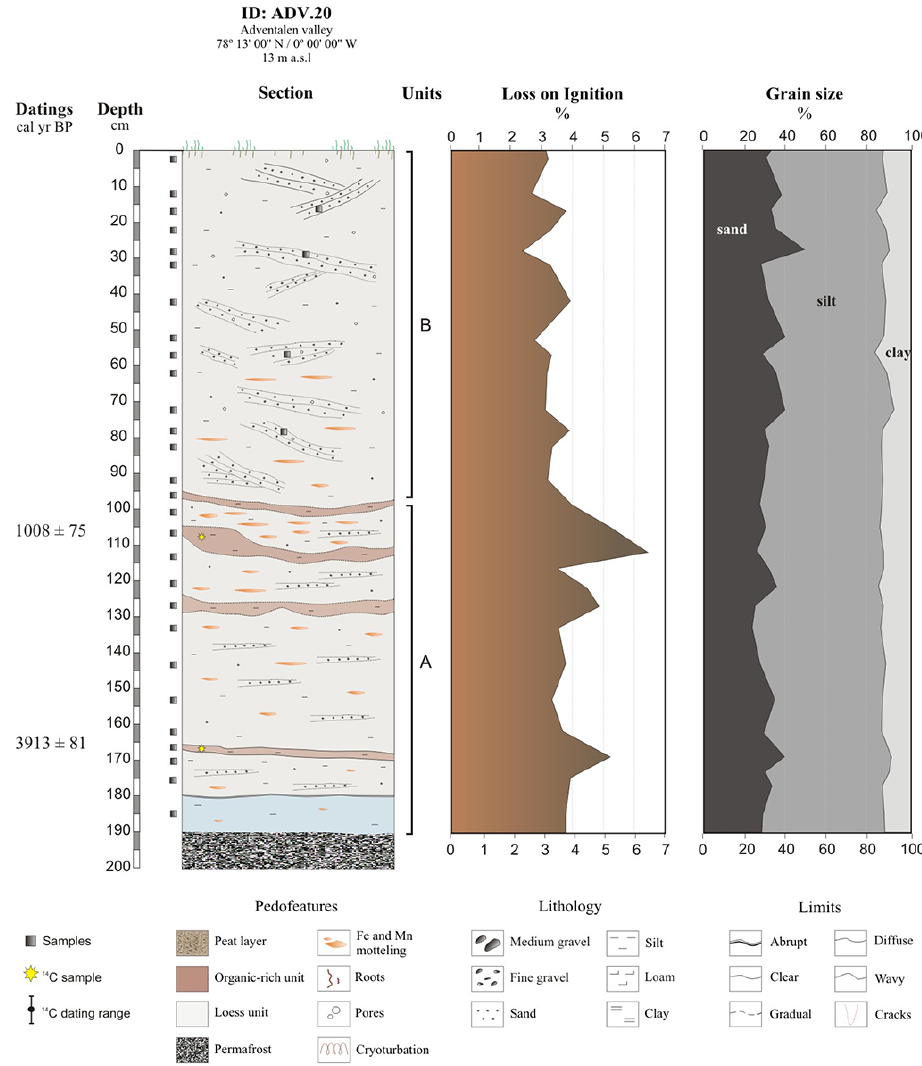
Figure 3. Lithostratigraphic section ADD.4 together with 14 C datings, LOI and grain size properties. Table 1. AMS 14 C datings performed on the samples. Radiocarbon ages have been calibrated using the CALIB 7.0 program and the IntCal13 curve (Reimer et al.,